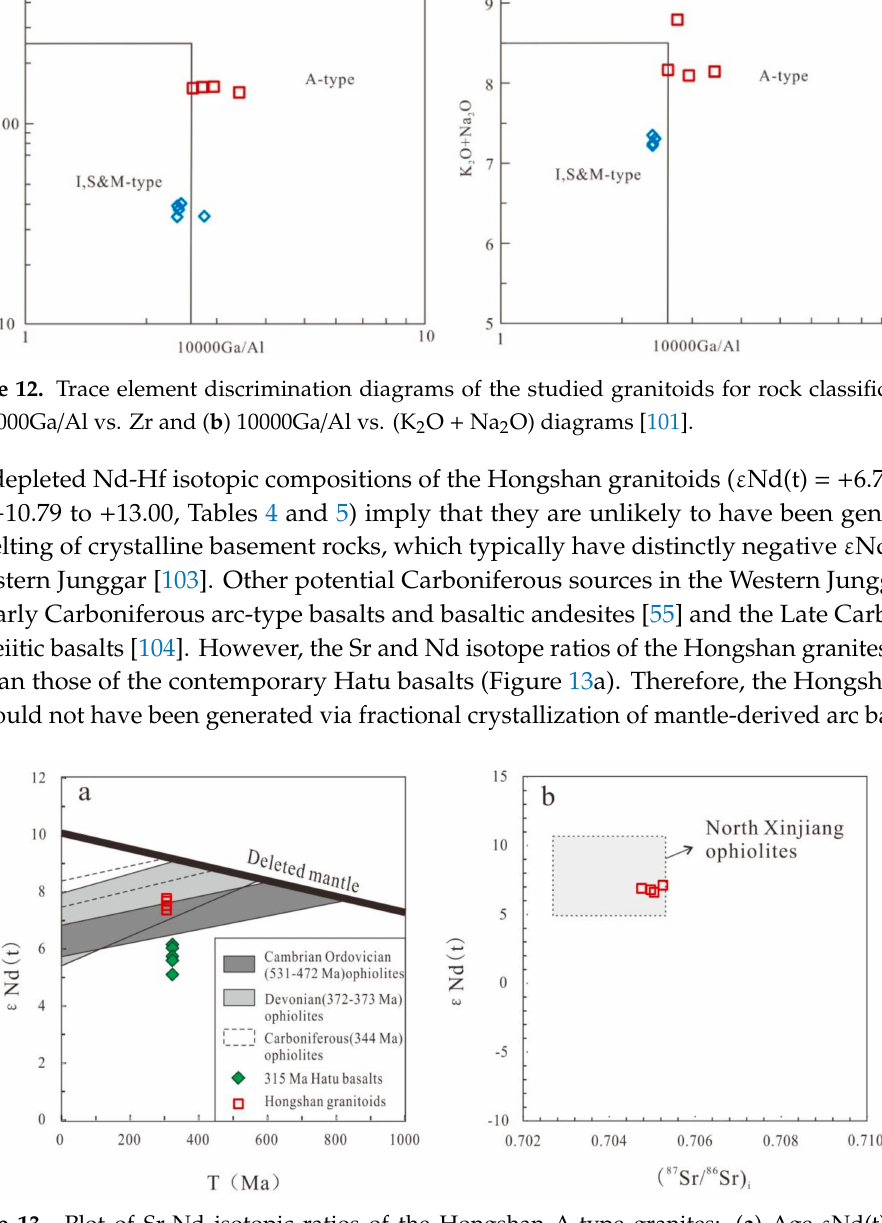
Figure 13. Plot of Sr-Nd isotopic ratios of the Hongshan A-type granites: ( a ) Age- ε Nd(t), and ( b ) ( 87 Sr / 86 Sr) i - ε Nd(t) diagram (Reference fields are from Tang et al. [48] and references